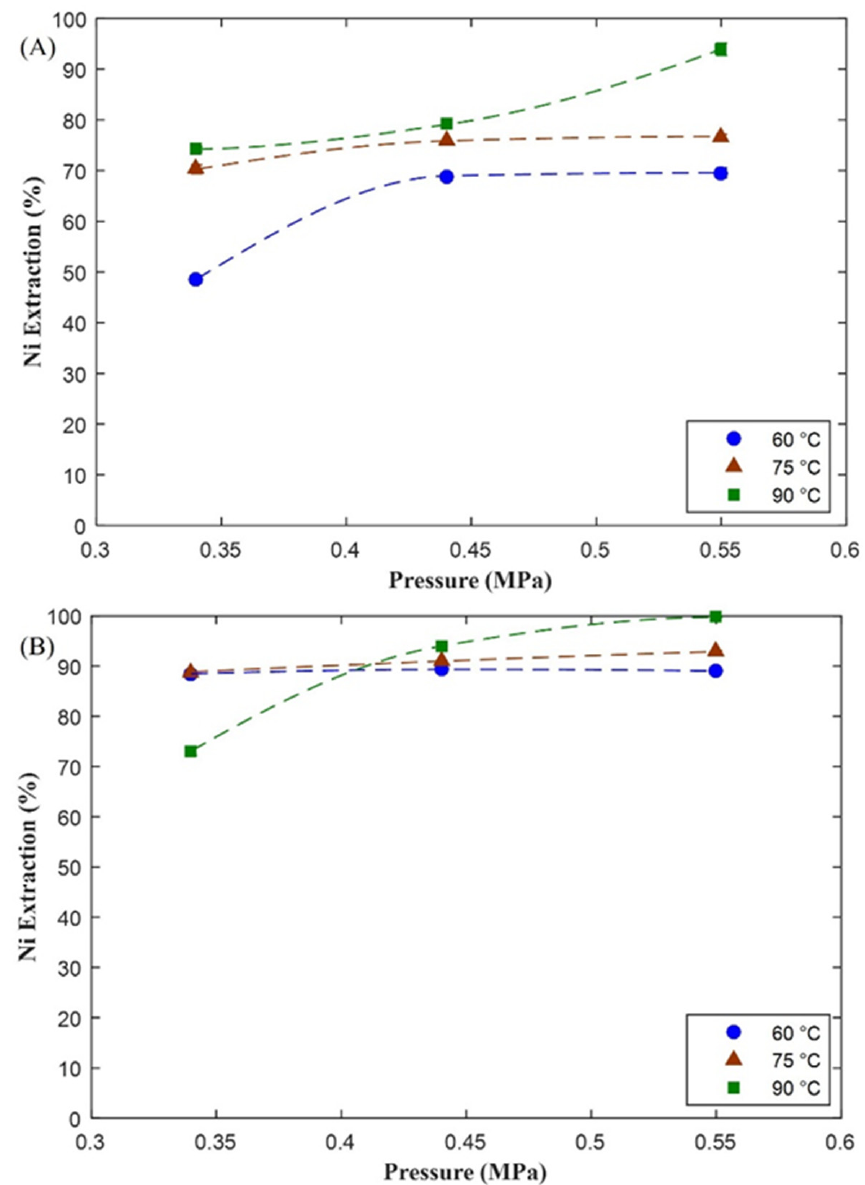
Figure 4. Ni extraction (%) as a function of pressure (MPa) at different temperatures (°C): ( A ) at 1 M H 2 SO 4 ; ( B ) at 2 M H 2 SO 4 (stirring at 600 rpm, for 4 h, 20% solids and a particle size of − 177 µ m).